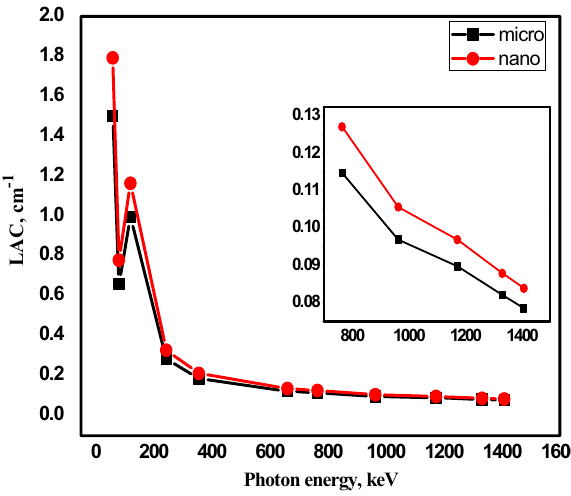
Figure 6. Comparison between LAC for nano- and micro-PbO for 20 wt% at different energy photon.